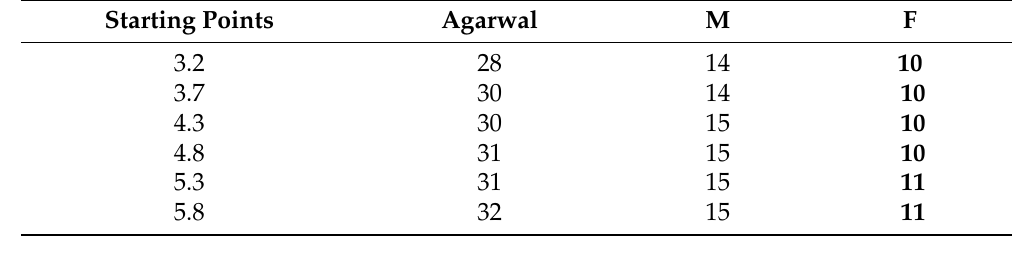
Number of Iterates for Obtaining Fixed Point.